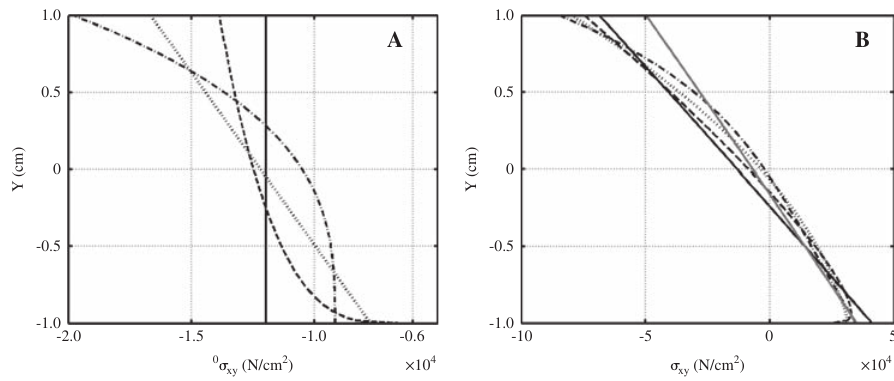
Figure 13 (A) Shear stress distributions in the geometrically linear case. (B) Cauchy shear stress distributions for various values of the power- law exponent at midpoint of the beam for q = 500 N/cm 2 . ( – – – – ) Full ceramic, ( – – – ) k = 0.3, (------) k = 1, ( – – – ) k = 3, ( – – – – ) full